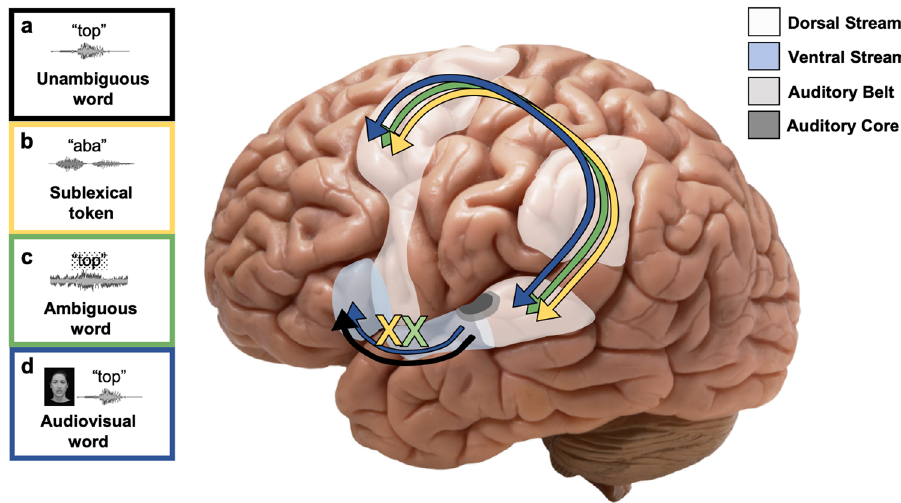
Fig. 1 Hypothesized dynamic, fl exible engagement of the dorsal and ventral streams. The ventral stream is represented in light blue and the dorsal stream in white. a Unambiguous lexical speech relies primarily on the ventral stream (black arrow). Ventral stream processing is insuf fi cient or inef fi cient for the processing of b sublexical tokens (yellow X) and c ambiguous/noisy lexical items (green X), and processing these items engages the dorsal stream (yellow/green arrows). d While ventral stream processing may be suf fi cient for audiovisual items, the presence of visual input stimulates obligatory motor